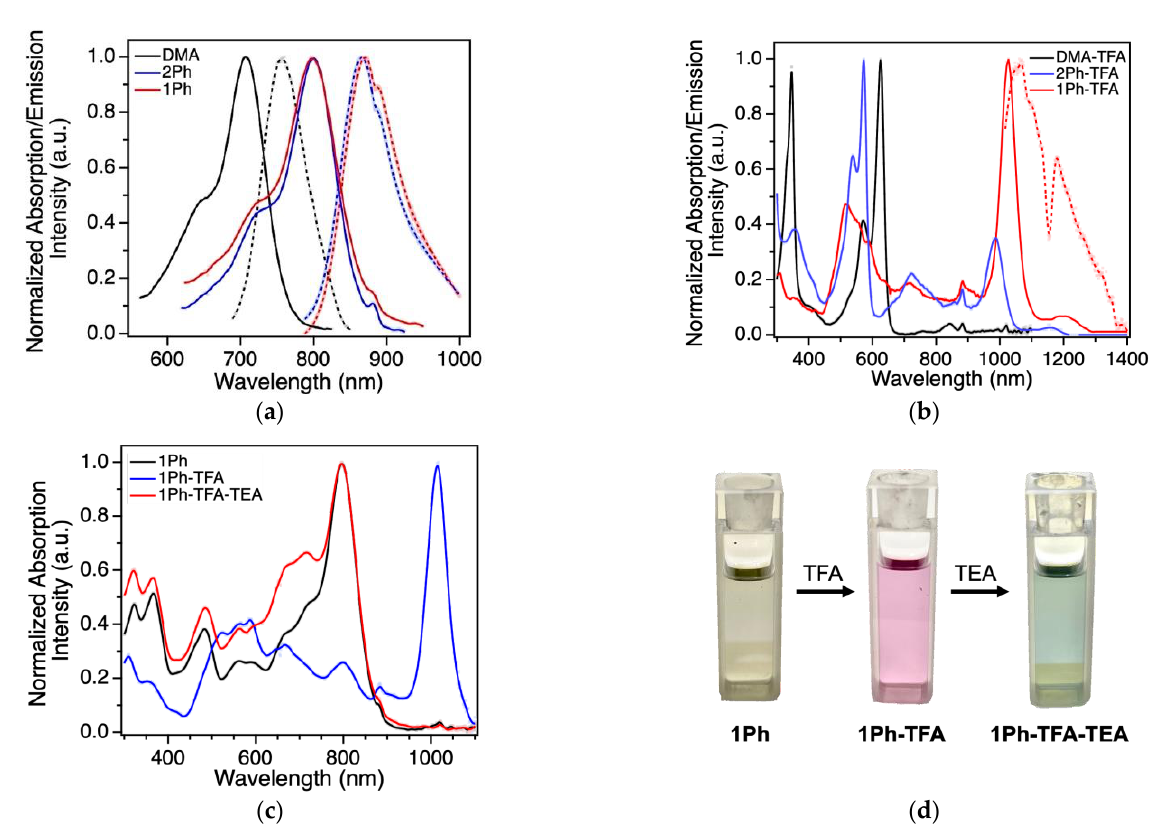
Figure 3. Photophysical studies of BODIPY dyes: ( a ) Absorption (solid line) and emission (dashed line) of neutral dyes DMA , 2Ph , and 1Ph in CH 2 Cl 2 ; ( b ) Absorption (solid line) of protonated dyes DMA-TFA , 2Ph-TFA , 1Ph-TFA , and emission (dashed line) of 1Ph-TFA in CH 2 Cl 2 . ( c ) Reversible protonation observed in the absorption curves of 1Ph , 1Ph-TFA , and 1Ph-TFA-TEA in DMSO- d 6 . ( d ) Photographs of the solutions used in graph ( c ).